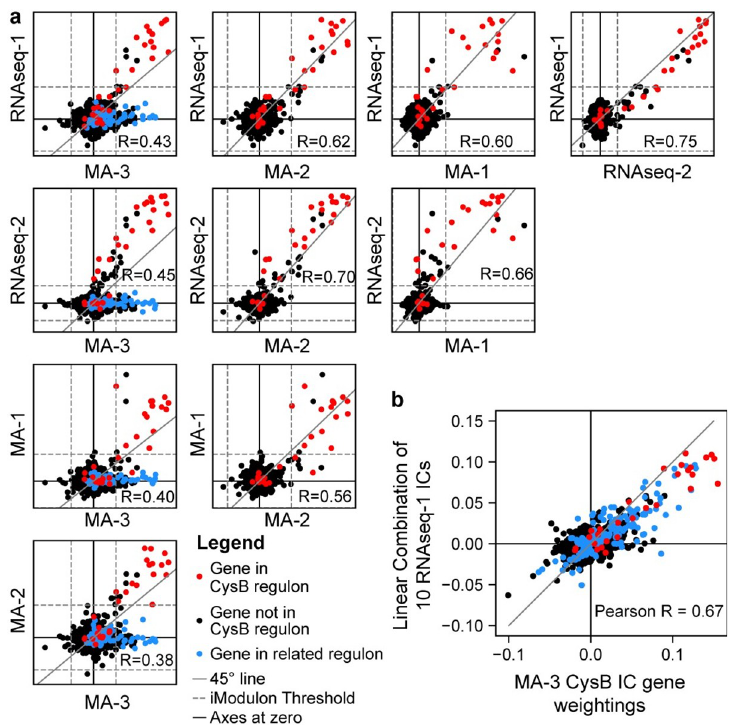
Fig 2. Comparison of IC gene weightings for iModulons enriched with genes in the CysB regulon. (A) Scatter plot between IC gene weightings for CysB-linked iModulons across all five datasets. Genes in the published CysB regulon are colored in red. For comparisons in the first column involving the MA-3 dataset, genes regulated by any of the following regulators are colored in blue: MetJ, TrpR, GlpR, ArgR, Lrp, CysB, leu-tRNA-mediated transcriptional attenuation, or thiamine riboswitch. All other genes are black. Dashed lines indicate iModulon thresholds. Gray solid lines indicate the 45-degree line of equal gene weightings. (B) Scatter plot between IC gene weightings for the CysB iModulon in MA-3 compared to a linear combination of 10 ICs from RNAseq-1 (see S1 Table). Color scheme is identical to panel (A).